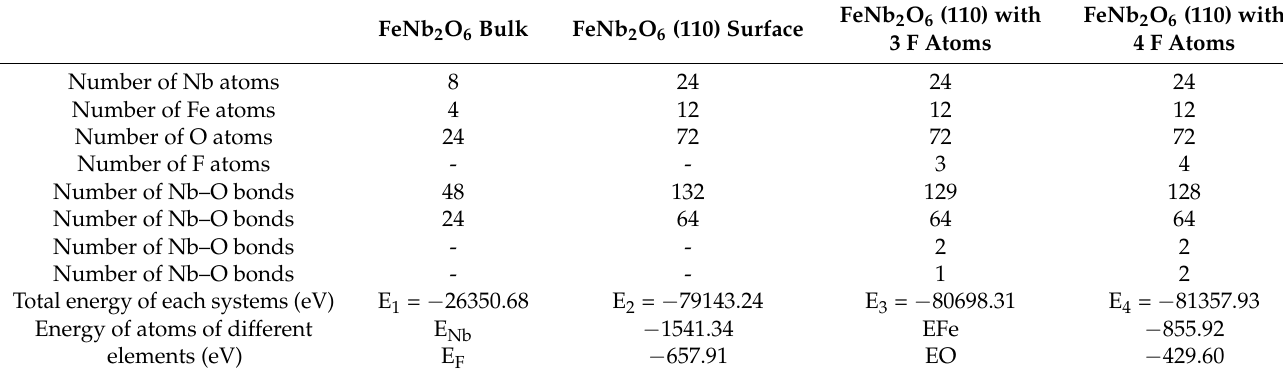
Table 6. The number of various atoms and bonds in different systems and the total energy of the system.